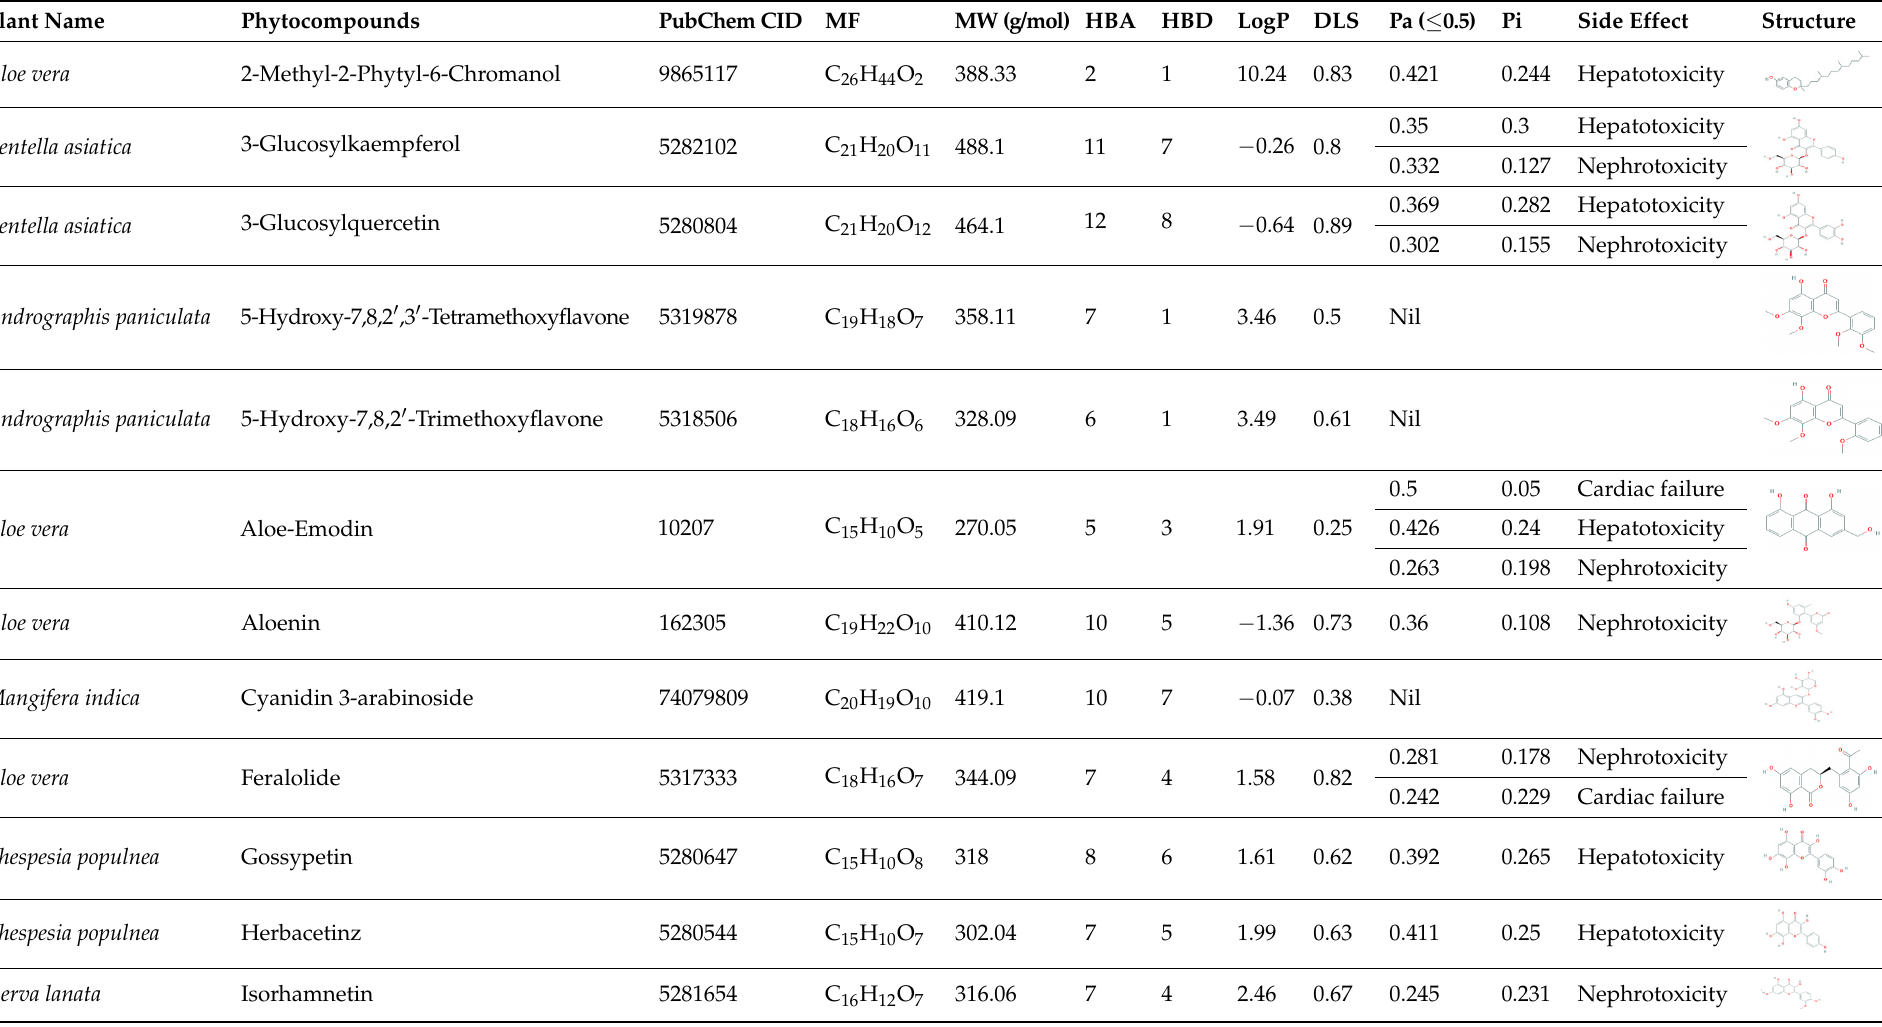
Table 1. Phytocompounds with positive for drug ‐ like properties and their toxicity profile.